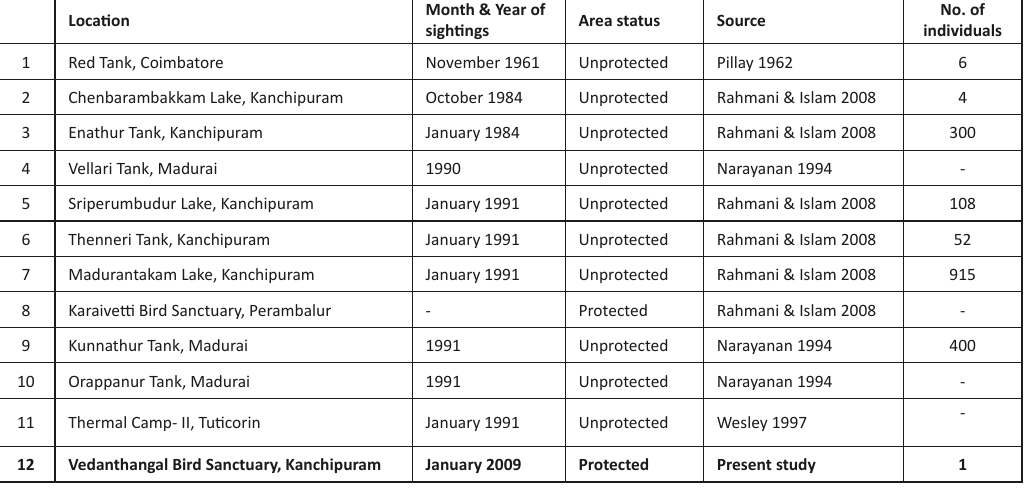
Table 1. Sighting records of Common Pochard in Tamil